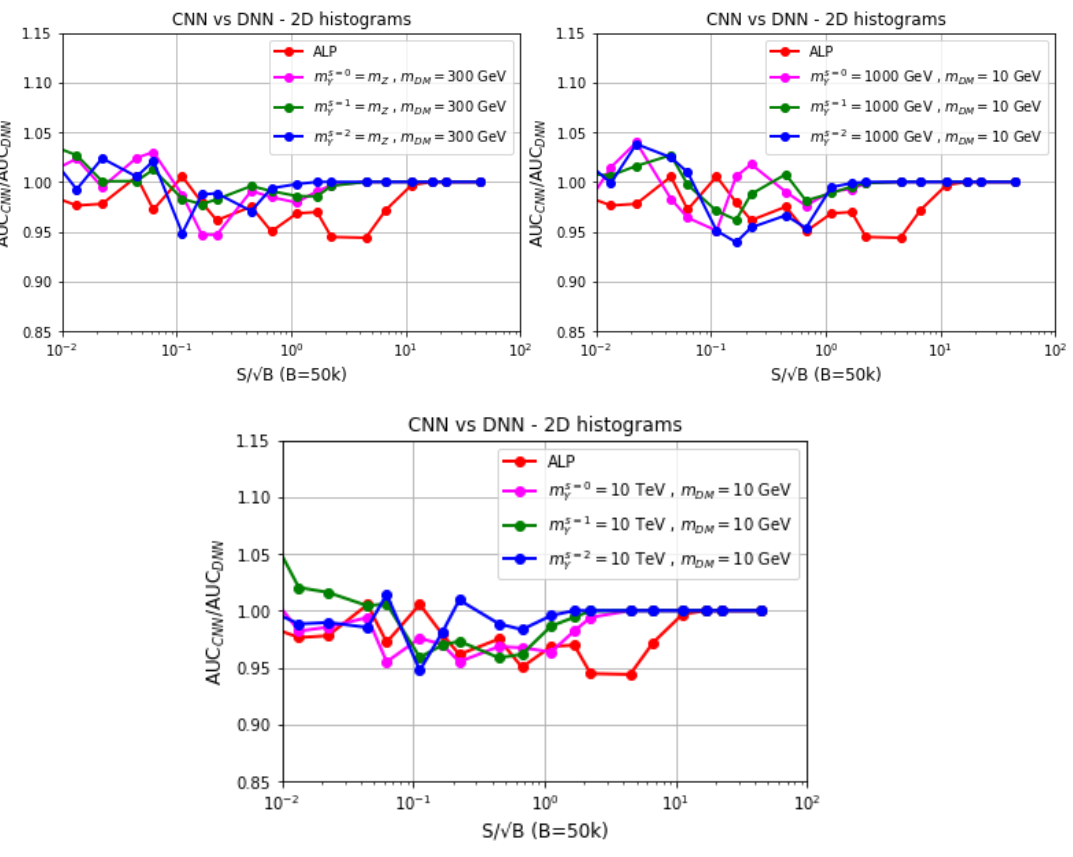
Figure 9: CNN AUCs divided by the DNN AUC for the benchmark models considered, using 2D histograms as input data. Each model is tested independently in a binary classifier to distinguish new physics plus SM vs SM-only